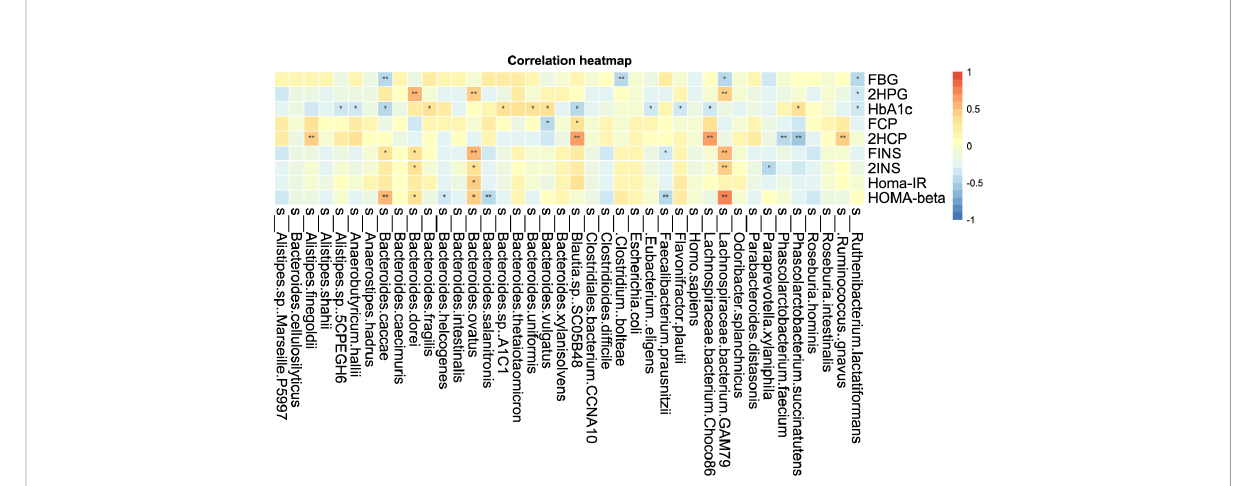
FIGURE 8-2 Correlation analysis of clinical indicators and species level difference bacteria after transplantation in Patients 1 and 2 *P-value <0.05, **P-value